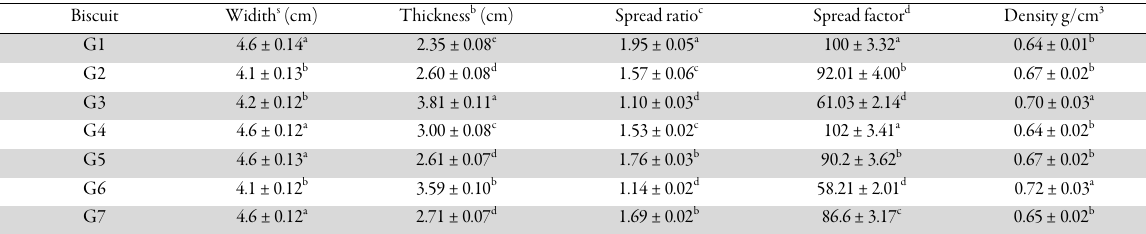
Table 11. Physical properties of colored barley flour biscuit made using the natural color and synthetic color (mg /100g dry weight) Biscuit